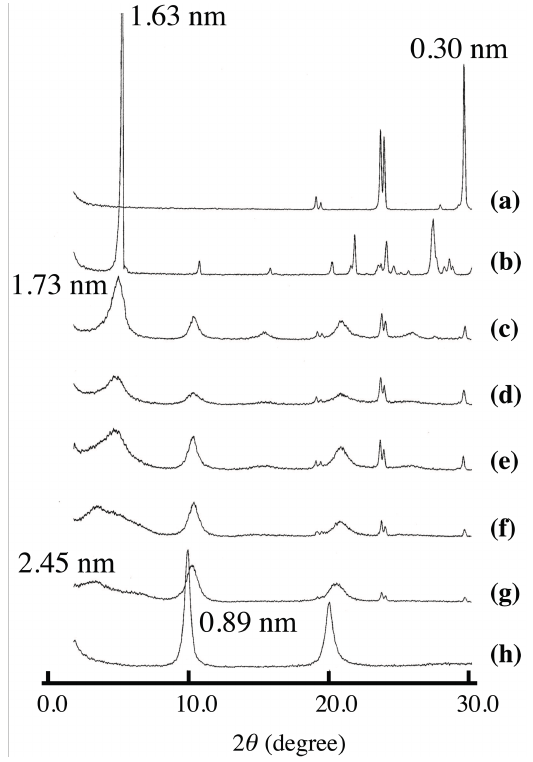
Figure 1. X-ray diffraction (XRD) patterns of ( a ) KNO and ( c – g ) layered double hydroxides (LDH)(NO for 5 min at room temperature (recorded before the samples were washed with water). ( c ) 4.7; ( d ) 3.3; ( e ) 2.8; ( f ) 2.3; ( g ) 1.3 mmol per 1 g LDH(NO LDH(NO ) is shown for 3